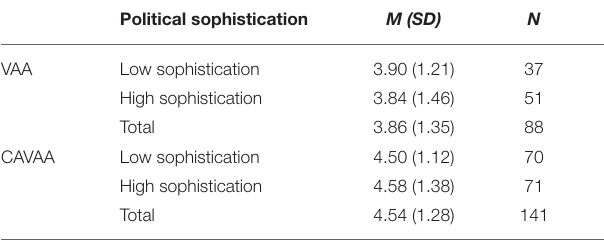
TABLE 3 | Means and Standard Deviations of perceived political knowledge score (ranging from 1 – a low perceived knowledge score to 7 – a high perceived knowledge score) in each condition.